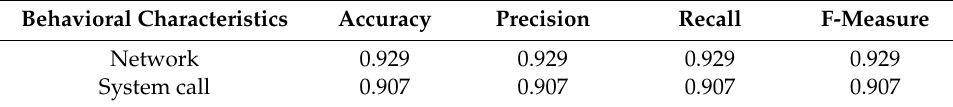
Table 3. Results of the selected dynamic behavioral characteristic evaluation.